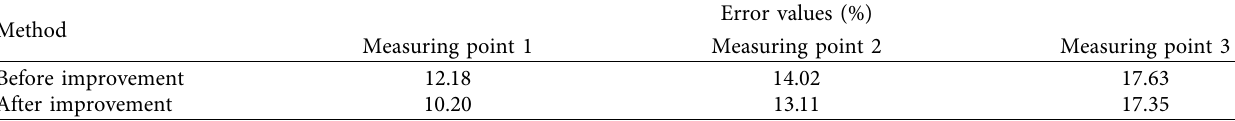
Table 3: Recognition error of three measuring point loads by traditional method and this paper’s